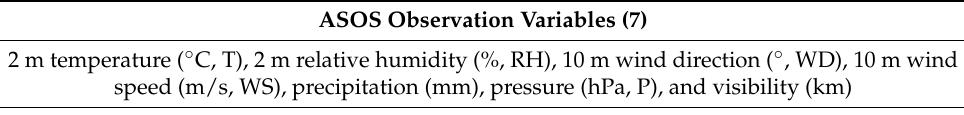
Table 1. Ground-based observation variables at the ASOS 72 sites (the parentheses are the KMA’s site classification number) and meteorological forecasting variables of the CAMS